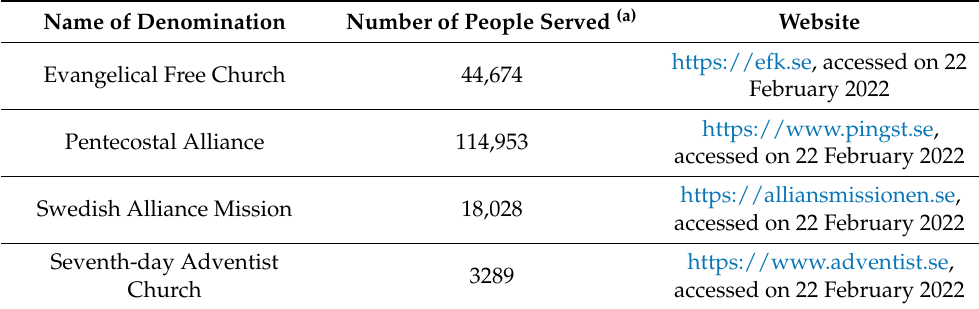
Table 1. Statistics about the selected denominations in the present